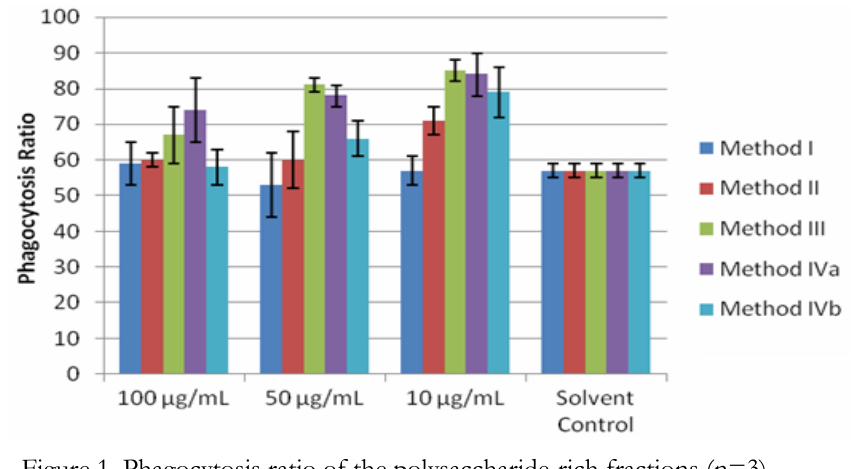
Figure 1. Phagocytosis ratio of the polysaccharide-rich fractions (n=3)